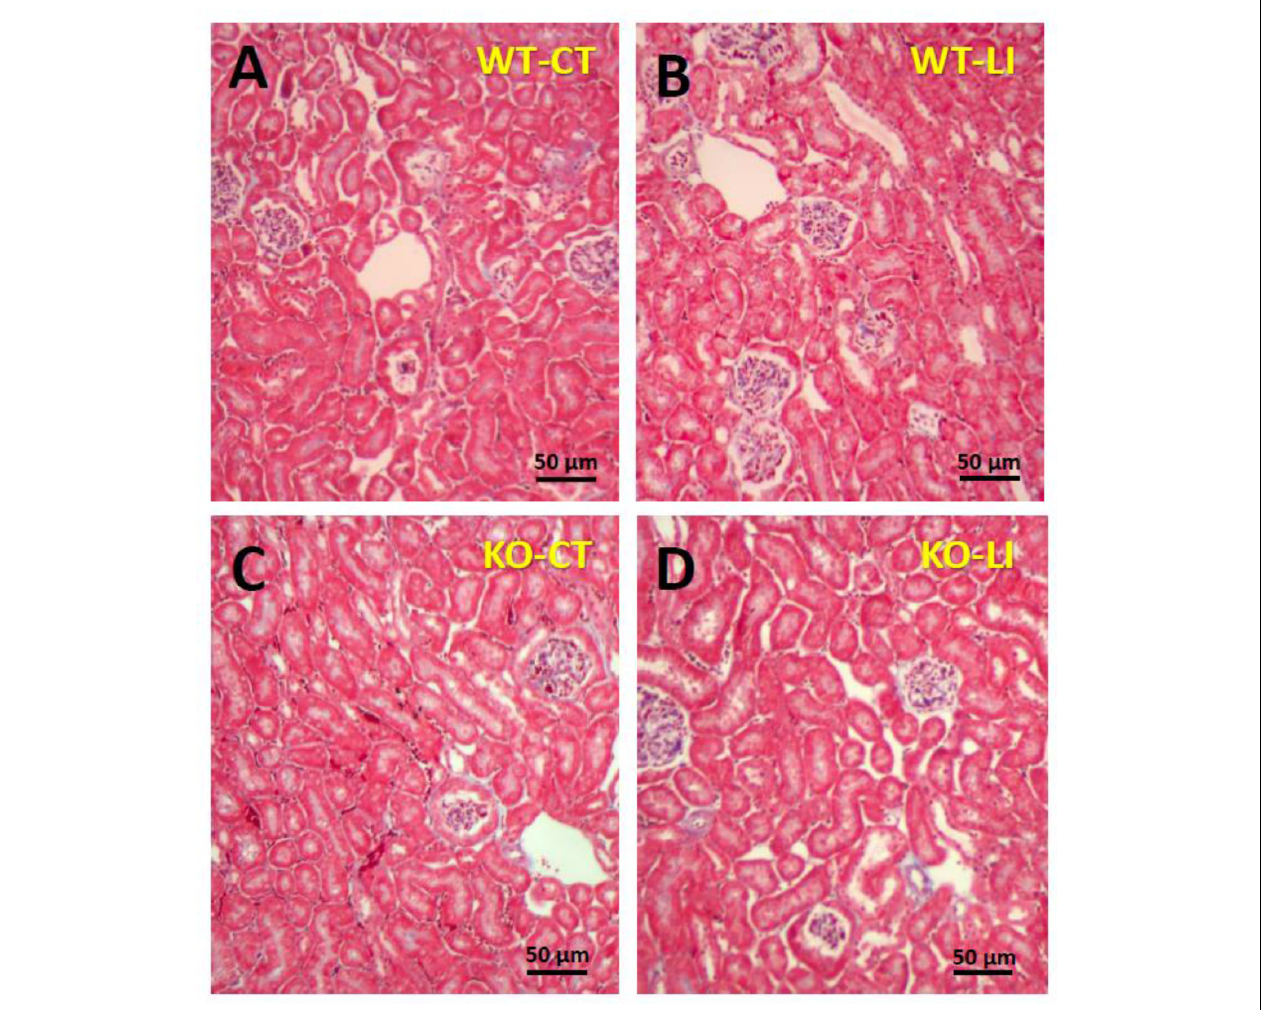
FIGURE 11 | Representative profiles of Masson’s trichrome stained kidney sections of WT and P2Y 2 KO mice fed control (CT) or lithium-added (LI) diets for 5 months. Formalin-fixed and paraffin-embedded kidney samples were sectioned and stained with Masson’s trichrome reagent. (A) WT control mouse; (B) WT lithium mouse; (C) KO control mouse; and (D) KO lithium